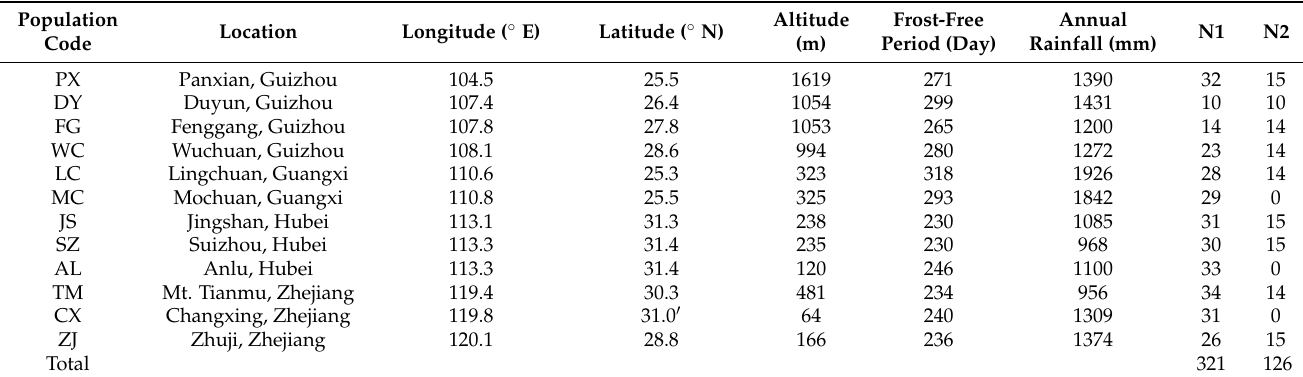
Table 1. Information on the ancient populations in this study.